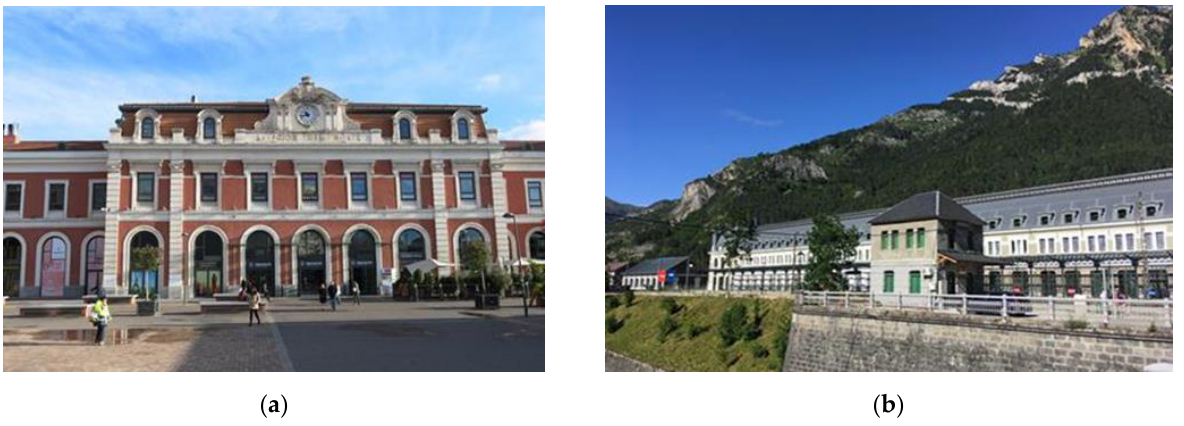
Figure 8. Architectural variables. Own elaboration.